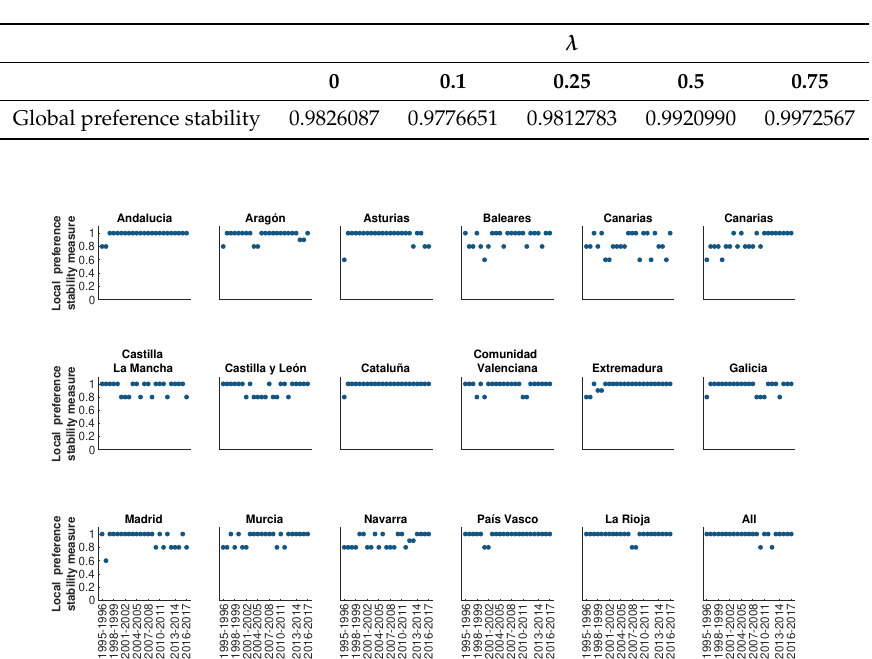
Figure A2. Graphic illustration of the global preferences stability measures for the entire society from different values of λ for Question 1. Table A2. Global stability measures for Spaniards’ preferences attending to several values of λ for Question 1.